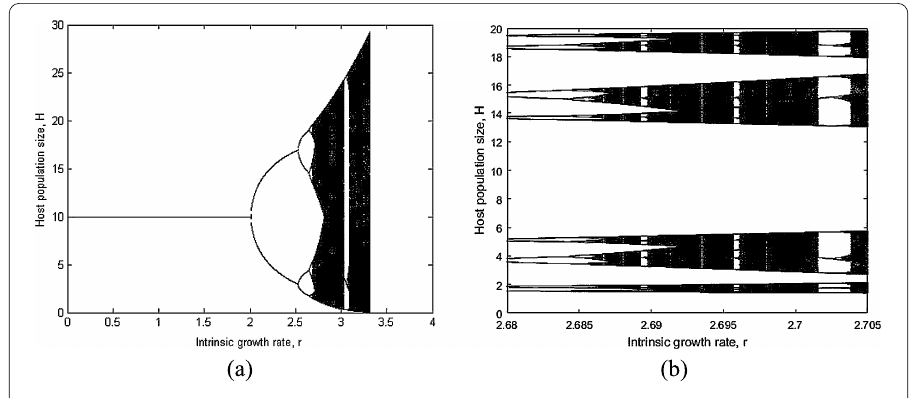
Figure 1 Numerical simulations of equation (3.1) ( a ) Flip bifurcation of system (3.1) for T = 1, T n = 0.4, b = 0.05, c = 0.2, m = 0.01, n = 0.05, K = 10, and 1.5 ≤ r ≤ 3, ( b ) NS-bifurcation of system (1.2) for 2.68 ≤ r ≤